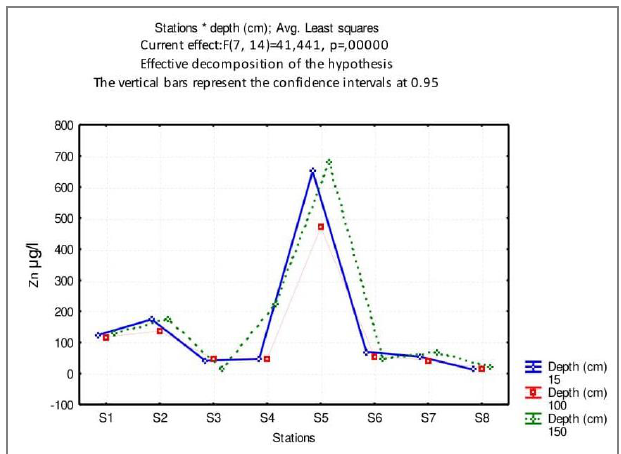
Figure 9. Spatial variation of Ni in μg / l in the Reghaia lake. Copper varies between 0.09 mg/L and 1.37μg/L upstream to the dam of the lake and 10 μg / L to 0.05 mg /L the surface to the depth during the month of April ( Figure 10 ). This corresponds to the maximum of primary productivity of the spring and can be connected to the fact that the copper between in the composition of various respiratory pigments (prothidic metal,chlorocruorin) Crustaceans constituting the zooplankton [29]